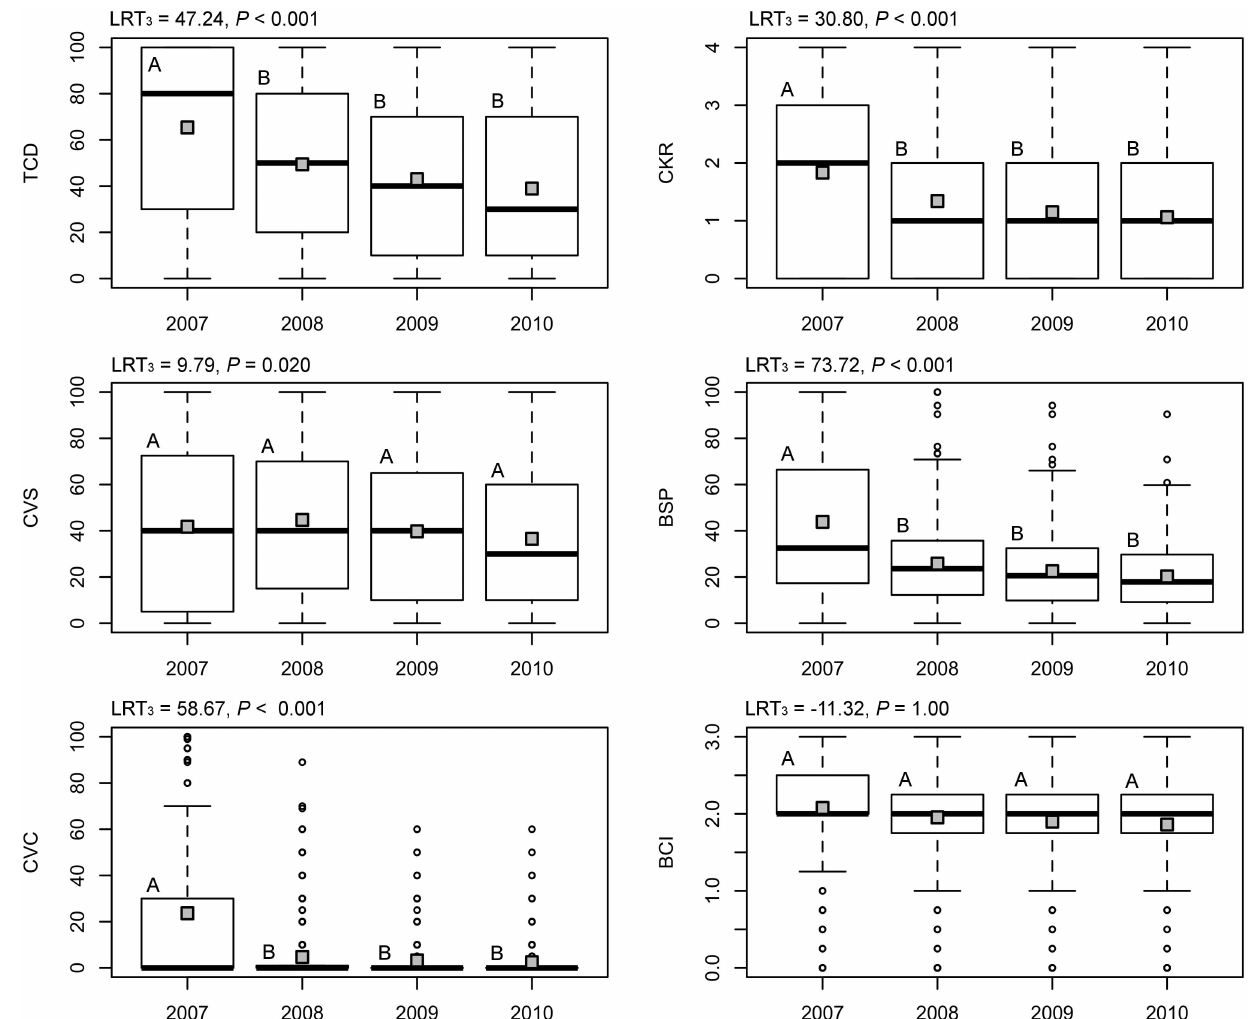
Fig 3. Changes in fire injury distributions among living ponderosa pine over time since fire. Dark lines within boxplots indicate the median and grey boxes indicate mean for six fire injury measurements. Different letters denote significant differences ( α (cid:20) 0.05) between years from generalizedlinear mixed models with Tukey HSD pairwise comparisons. All trees were consideredlive in